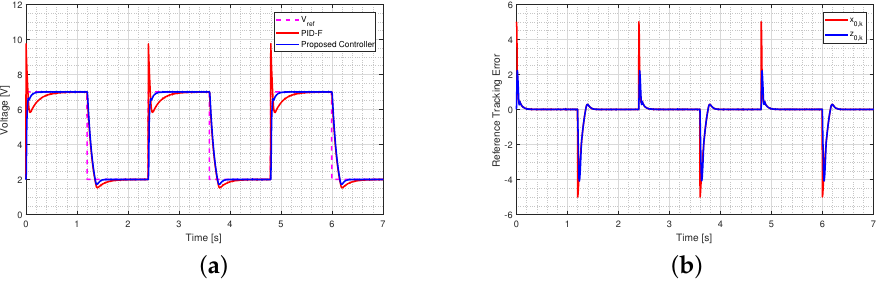
Figure 5. Output voltage tracking performance of the proposed controller and a saturated discrete − time PID with τ = 250 µ s. ( a ) Output voltage and reference; ( b ) reference tracking error and its